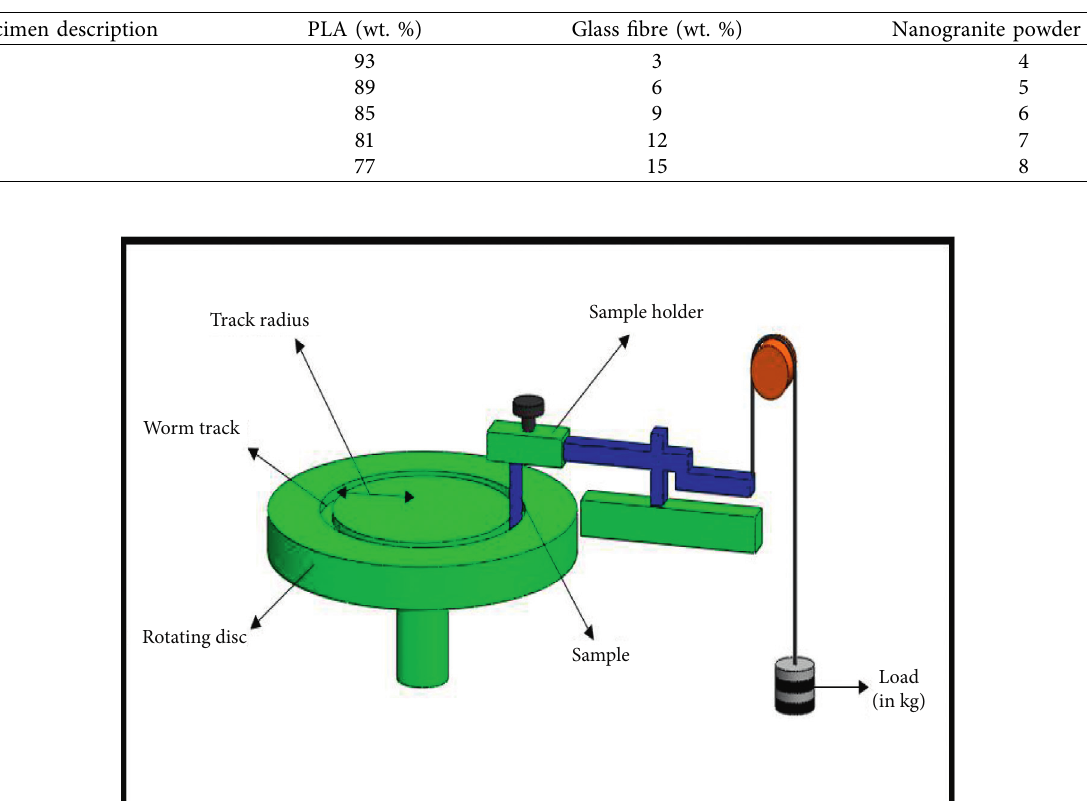
Figure 6: Schematic diagram of pin on disc apparatus.